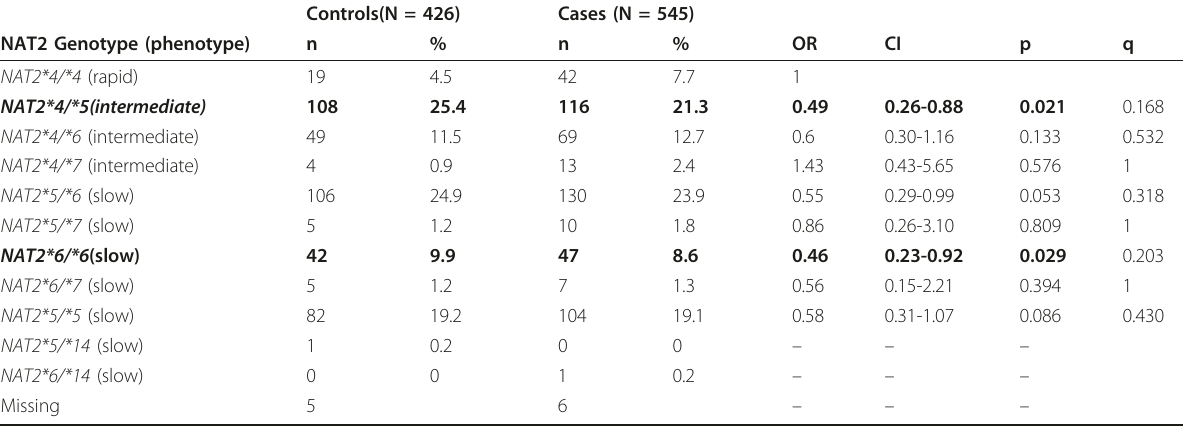
Table 6 Case-control comparison of NAT2 genotypes